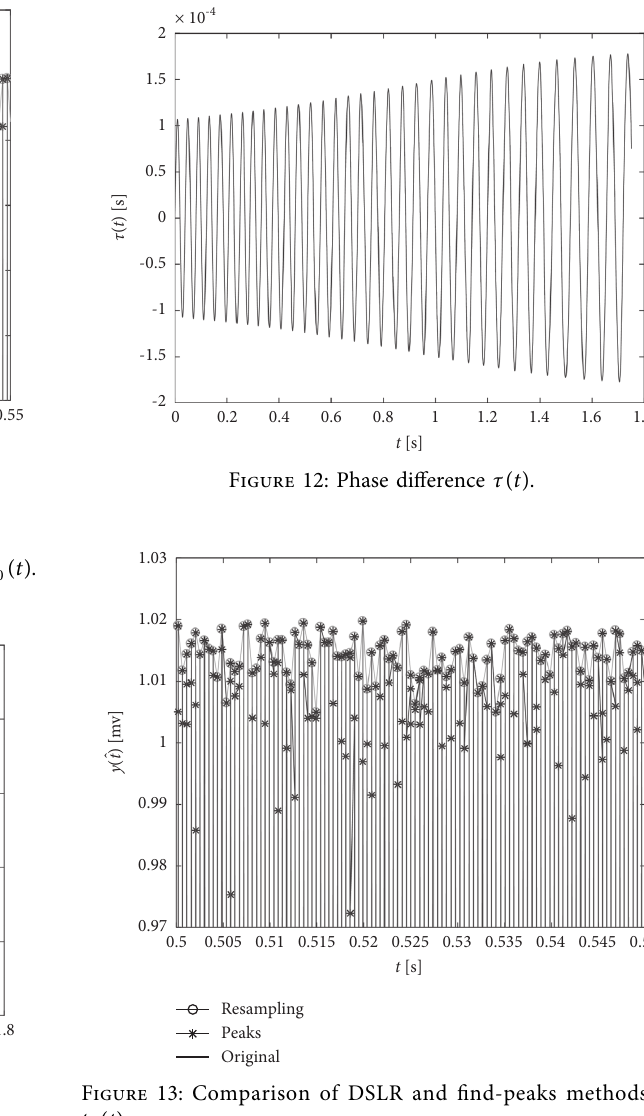
Figure 13: Comparison of DSLR and find-peaks methods on ( t ) t τ